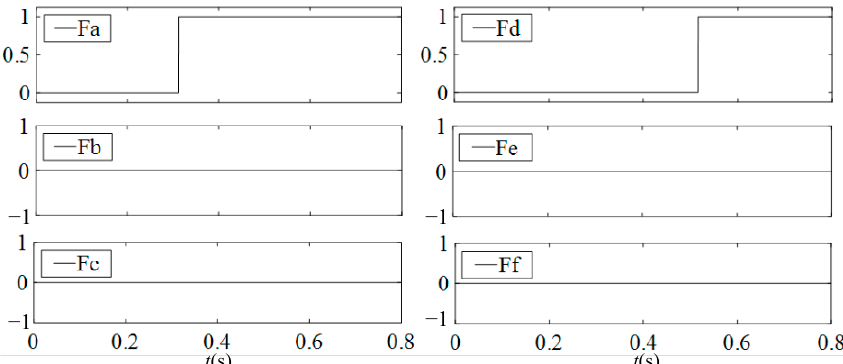
Figure 14. Fault index waveforms of phase a and phase d at 0.3 s and 0.5 s open-circuit fault, respectively. The current waveform of the open-circuit fault of phase a and phase f at 0.3 s and 0.5 s is shown in Figure 15. The load torque is 30 N · m, the phase failure of phase a and phase f occurs at 0.3 s and 0.5 s, respectively. The phase a current becomes zero after 0.3 s and the phase f current also becomes zero after 0.5 s. Among the remaining four-phase currents, phase b and phase c have the same amplitude and opposite phase. Similarly, phase d and phase e have the same amplitude and opposite phase.